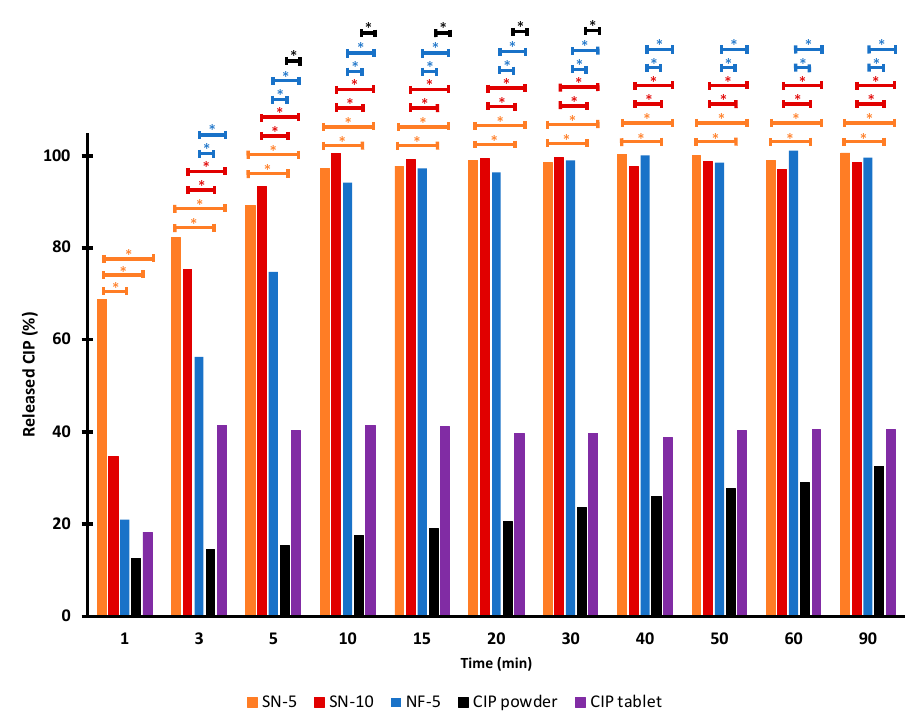
Figure 7. Average ciprofloxacin (CIP) release at the sampling points. * means significantly different ( p < 0.01) values calculated using one-way ANOVA, with post hoc Tukey HSD testing of each sample, pair by pair.